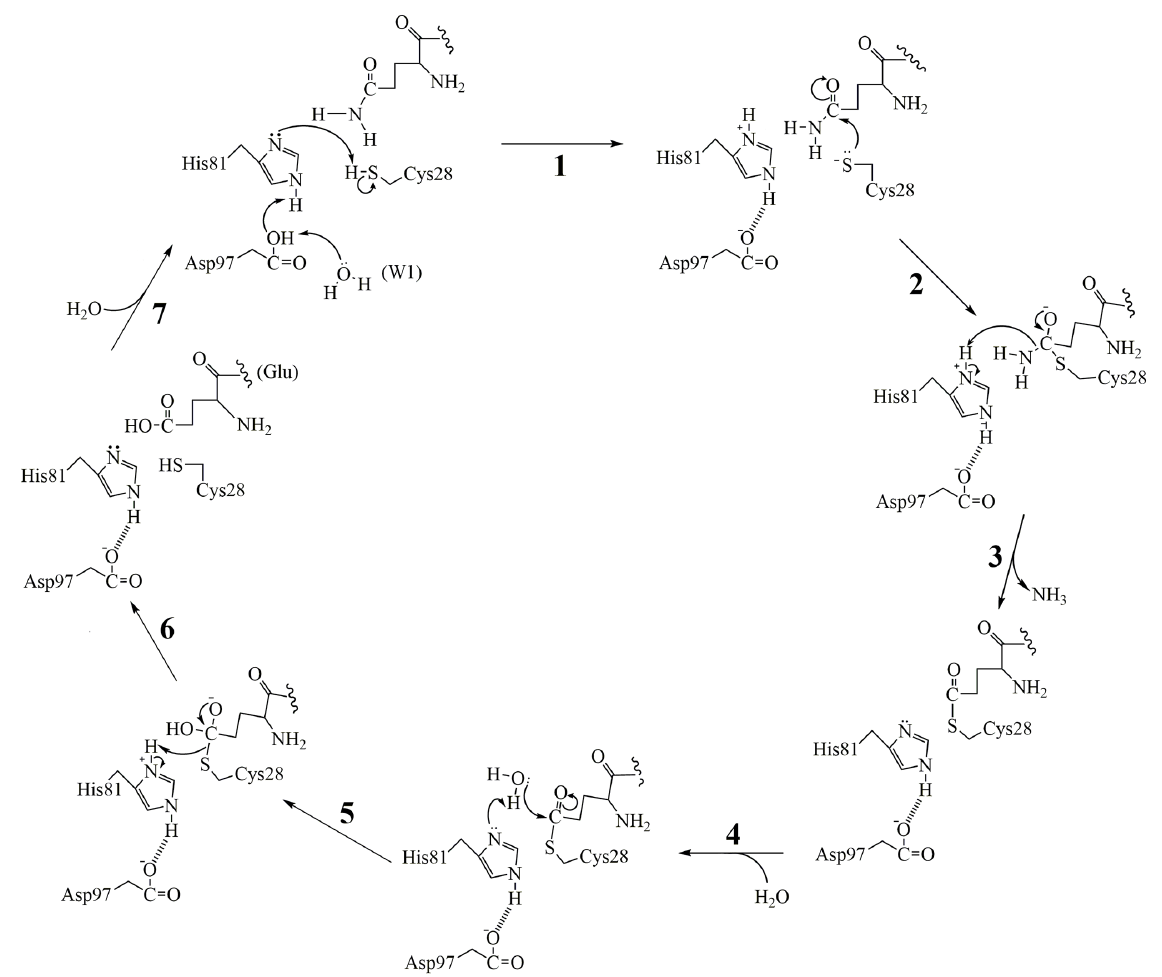
Figure 4. Proposed catalytic mechanism of hNtaq1.